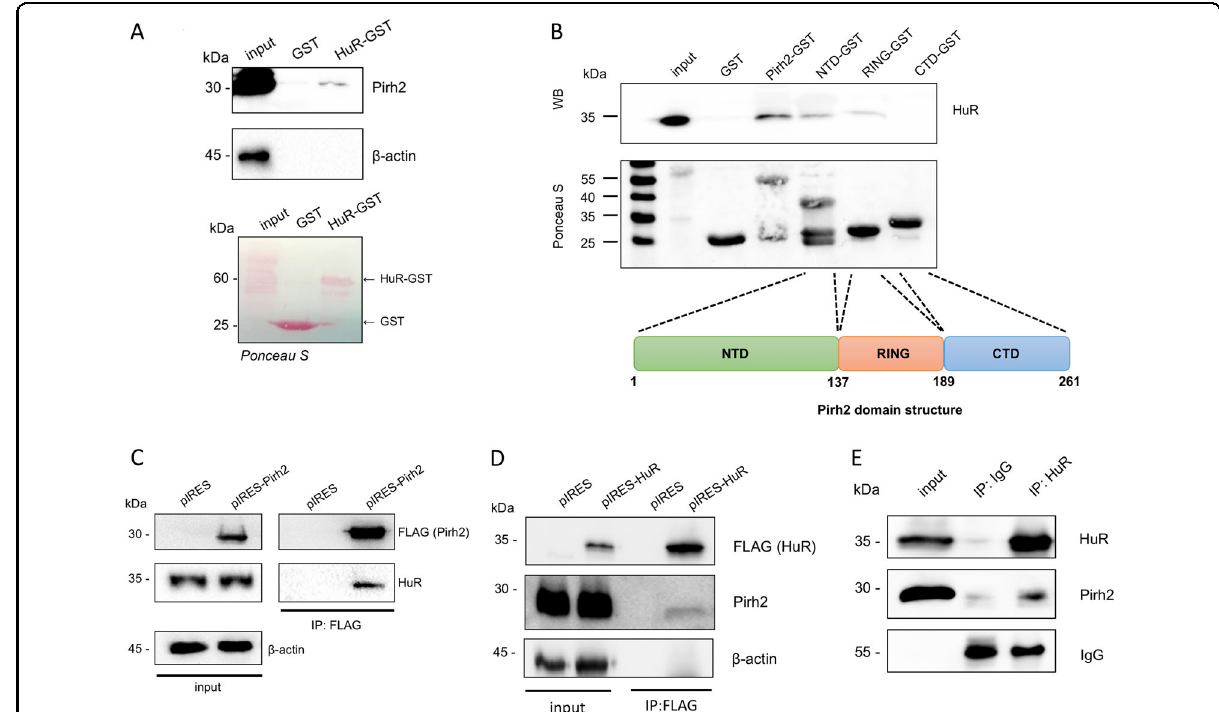
Fig. 2 Pirh2 binds to HuR in vitro and in cellulo. A HuR-GST interacts with Pirh2. GST-pulldown assay with extracts from HEK293T, demonstrating the interaction of HuR-GST with Pirh2. A Ponceau-stained membrane. HuR-GST fusion protein and native GST protein are denoted with arrows (left); western blot analysis of Pirh2 binding to GST and HuR-GST (right). B Identi fi cation of the Pirh2 domains involved in HuR binding. WB analysis of GSTpull-down assay with puri fi ed GST-tagged proteins: GST, full-length Pirh2 (Pirh2-GST), the N-terminal domain of Pirh2 1 – 132 a.a. (NTD-GST), the RING domain of Pirh2 138 – 189 a.a. (RING-GST), and the C-terminal domain of Pirh2 190 – 261 a.a. (CTD-GST) (upper panel); the scheme demonstrating the Pirh2 domain structure (bottom panel). C Pirh2 interacts with HuR in cellulo. Western blot analysis of co-immunoprecipitation in HEK293T cells of ectopically expressed Pirh2-3×FLAG (pIRES-Pirh2) and endogenous HuR. An empty pIRES vector was used as negative control. D HuR interacts with Pirh2 in cellulo. Western blot analysis of co-immunoprecipitation in HeLa cells of ectopically expressed HuR-3×FLAG (pIRES-HuR) and endogenous Pirh2. An empty pIRES vector was used as negative control. E Co-immunoprecipitation of the endogenous HuR and Pirh2 proteins using anti-HuR monoclonal